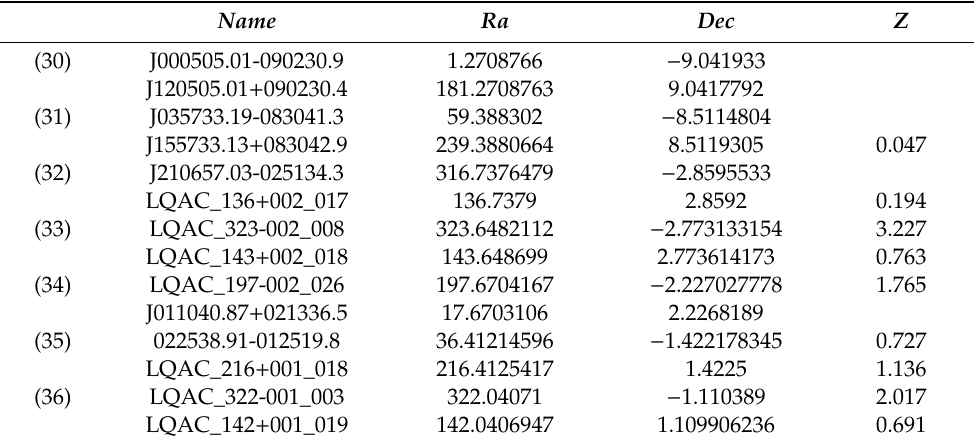
Table A19. Pairs of opposite quasars from the KQCG catalog for the cosmic mirror e ff ect (abbr.